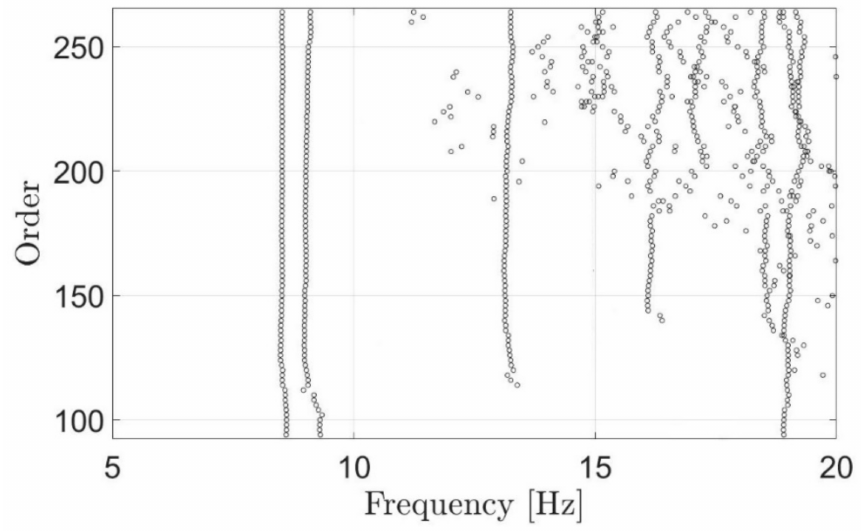
Figure 10. Stabilization diagram obtained from SS-I cov analysis on the first setup. Table 2 summarizes the identified modal parameters.